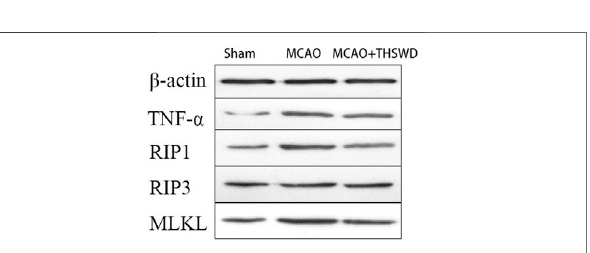
Frontiers in Pharmacology |